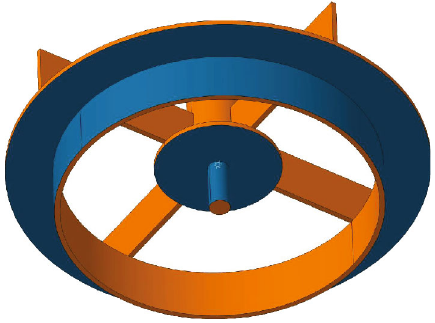
Figure 8: Bottom view of a foot equipped with two